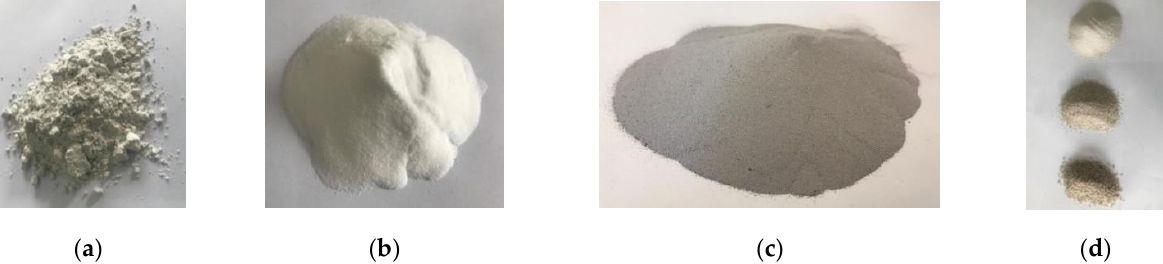
Figure 1. Raw materials used for the design of AAMs with M3DPWP: ( a ) GGBFS; ( b ) WG; ( c ) M3DPWP; ( d ) aggregates.